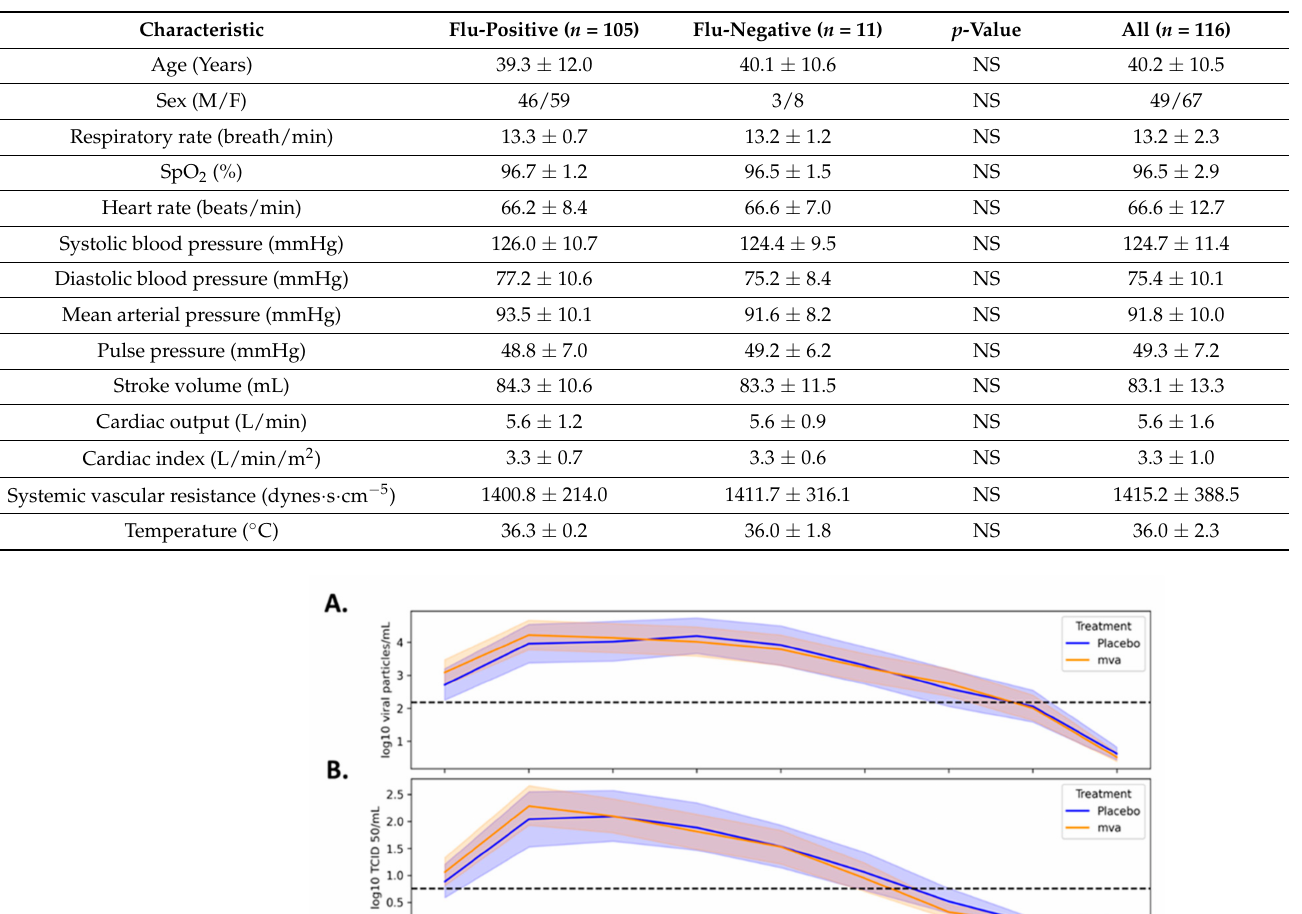
Table 1. General characteristics of the participants, and average baseline values of the physiological parameters collected during the study. NS, not significant.